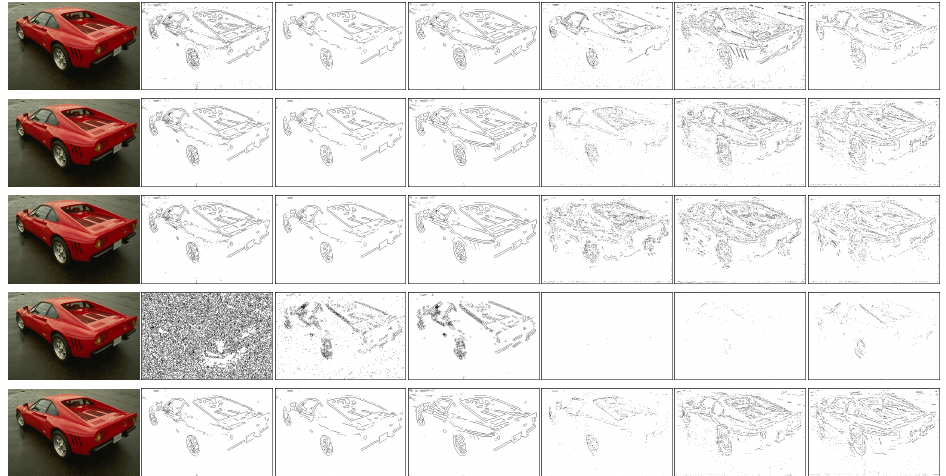
Figure A11. Marr–Hildreth operators and Shen–Castan operator results. Columns: Original, MH kernel 3 × 3, MH kernel dilated 5 × 5, MH kernel dilated 7 × 7, SC kernel 3 × 3, SC kernel dilated 5 × 5 and SC kernel dilated 7 × 7. Rows: Laplace kernel V1, Laplace kernel V2, Laplace kernel V3, Laplace kernel V4 and Laplace kernel